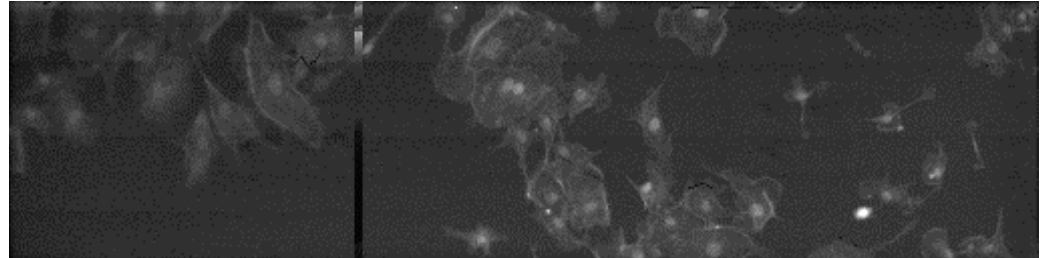
Figure 12. Widefield fluorescence imaging of BPEA QGS cellular clusters labeled with MitoTracker Red CMX Ros, Alexa Fluor 488, and DAPI dyes (magnification = 10×). The dead column in the image Red CMX Ros, Alexa Fluor 488, and DAPI dyes (magnification = 10 ˆ ). The dead column in the image is due to a false connection between the imager and the FPGA. is due to a false connection between the imager and the FPGA.